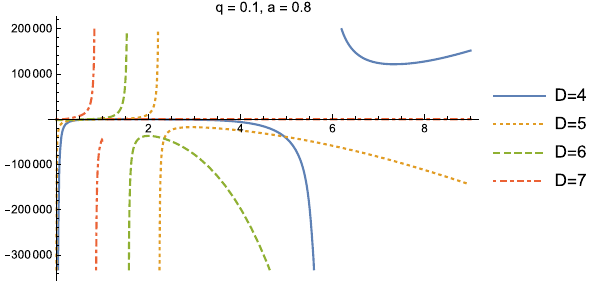
Fig. 16 Heat capacity in third order Lovelock gravity as function of r h , for a = 0 . 8 and q = 0 .